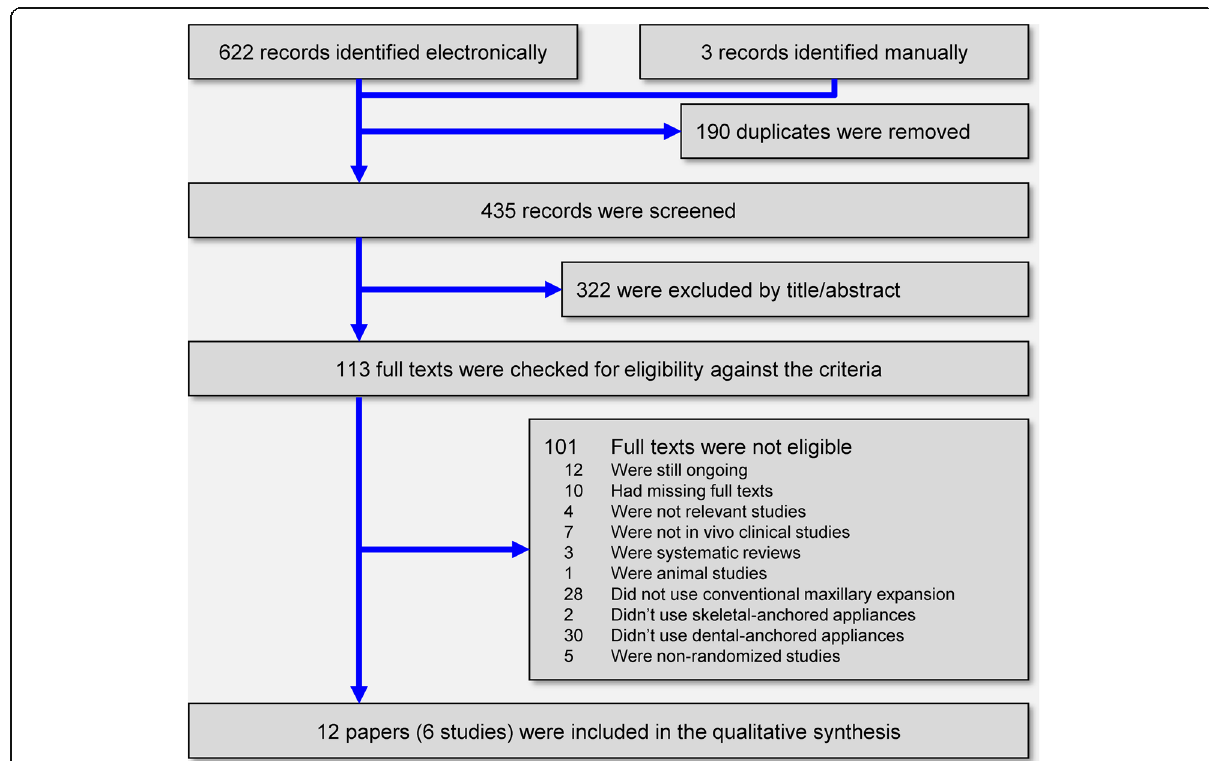
Fig. 1 PRISMA flow diagram for identification and selection of eligible